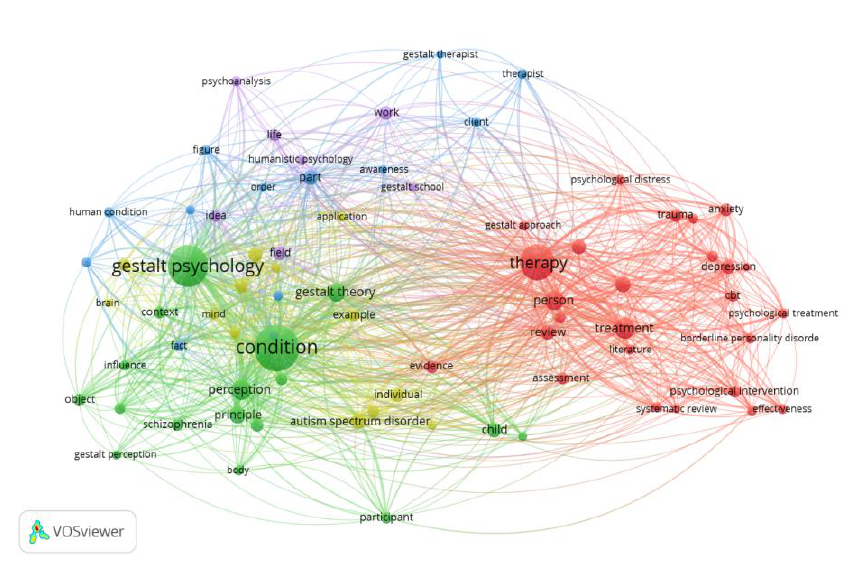
Figure 1. Bibliometrics using